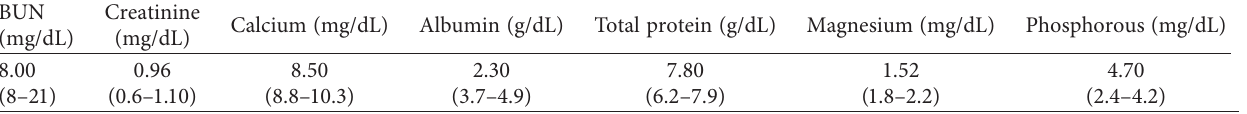
Table 3: Laboratories at the moment of